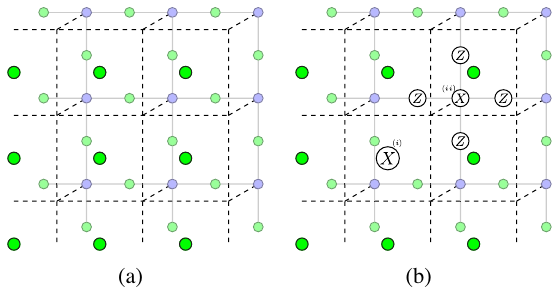
FIG. 9. (a) The lattice at the sink boundary. Primal qubits are depicted in green, while dual qubits are depicted in blue. (b) The dual boundary Hamiltonian H consists of cluster terms, as PD depicted by (i) and (ii). The primal qubits on the boundary surface have no neighbors (meaning the corresponding cluster term is given simply by Pauli X ). Bold lines indicate nearest-neighbor relations between qubits, while dashed lines indicate edges of the ambient cubic